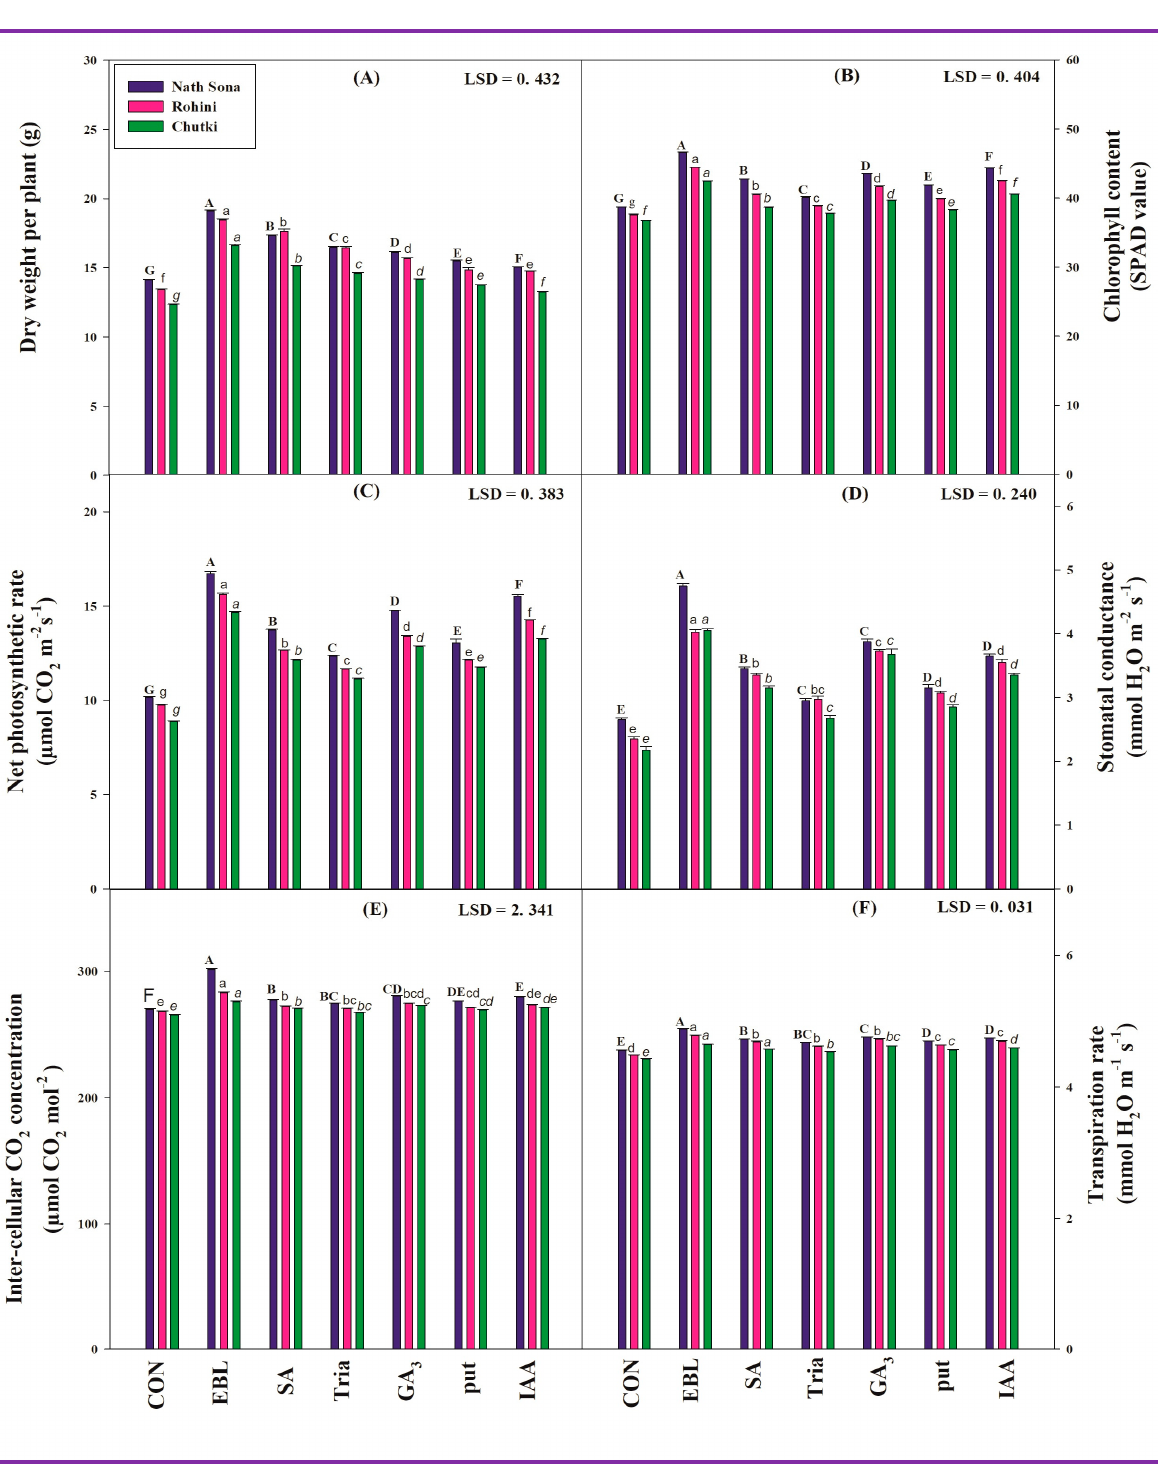
Figure 3. Effect of foliar spray of PGRs on ( A ) Dry weight per plant, ( B ) Chlorophyll content, ( C ) Net photosynthetic rate, ( D ) Stomatal conductance, ( E ) Inter-cellular CO 2 concentration and ( F ) Transpiration rate of the mustard cultivars Nath Sona, Rohini and Chutki. Data are treatment means with the standard error (±SE) of four replicates. The different small and capital letters represent a significant difference in three cultivars among various treatments confirmed through Duncan’s Multiple Range test at p ≤ 0.05.